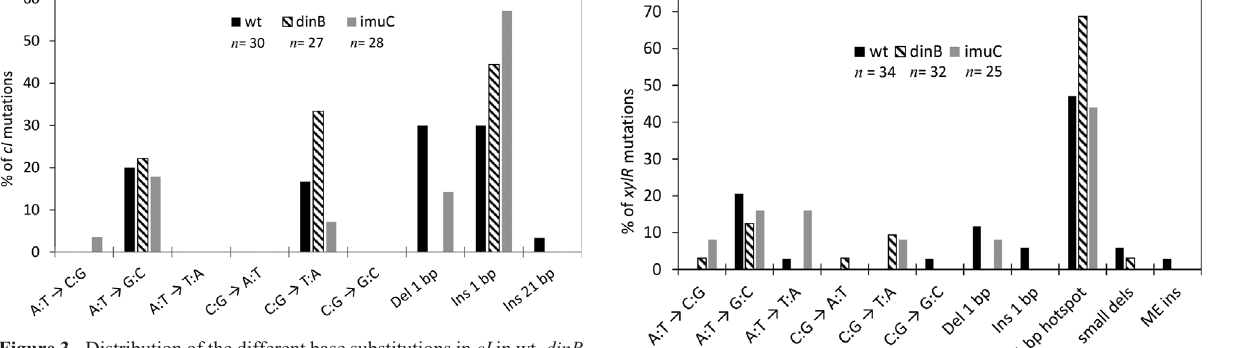
Figure 3 - Distribution of the different base substitutions in cI in wt, dinB and imuC strains. Results are shown for NA1000 strain (wt) and mutant strains ( dinB and imuC ). n indicates the number of mutants analyzed in each strain. The different base substitutions are indicated. Del 1 bp: 1 bp deletions. Ins 1 bp: 1 bp insertions. Ins 21 bp: 21 bp insertion detected in the wt strain.